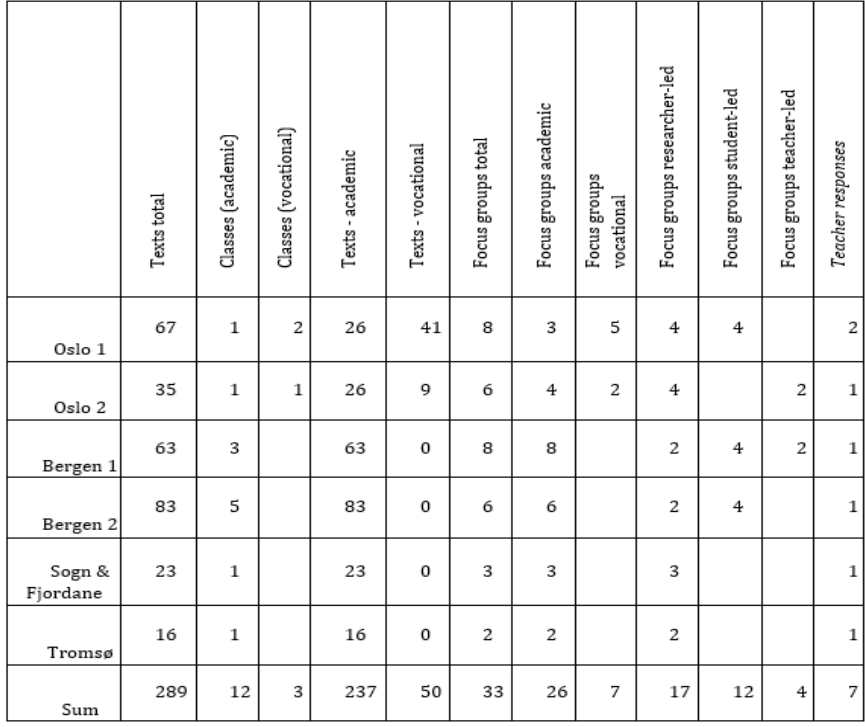
Table 1 details our data: